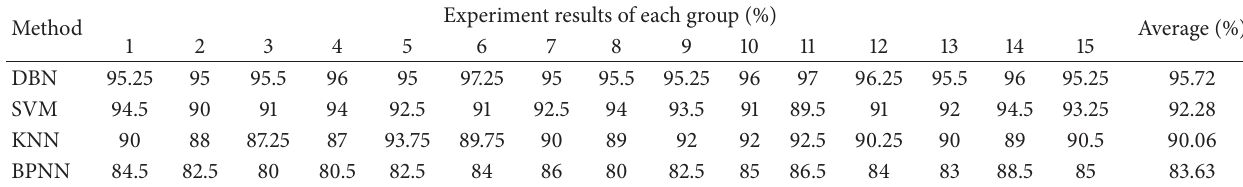
Table 5: Results of training datasets.